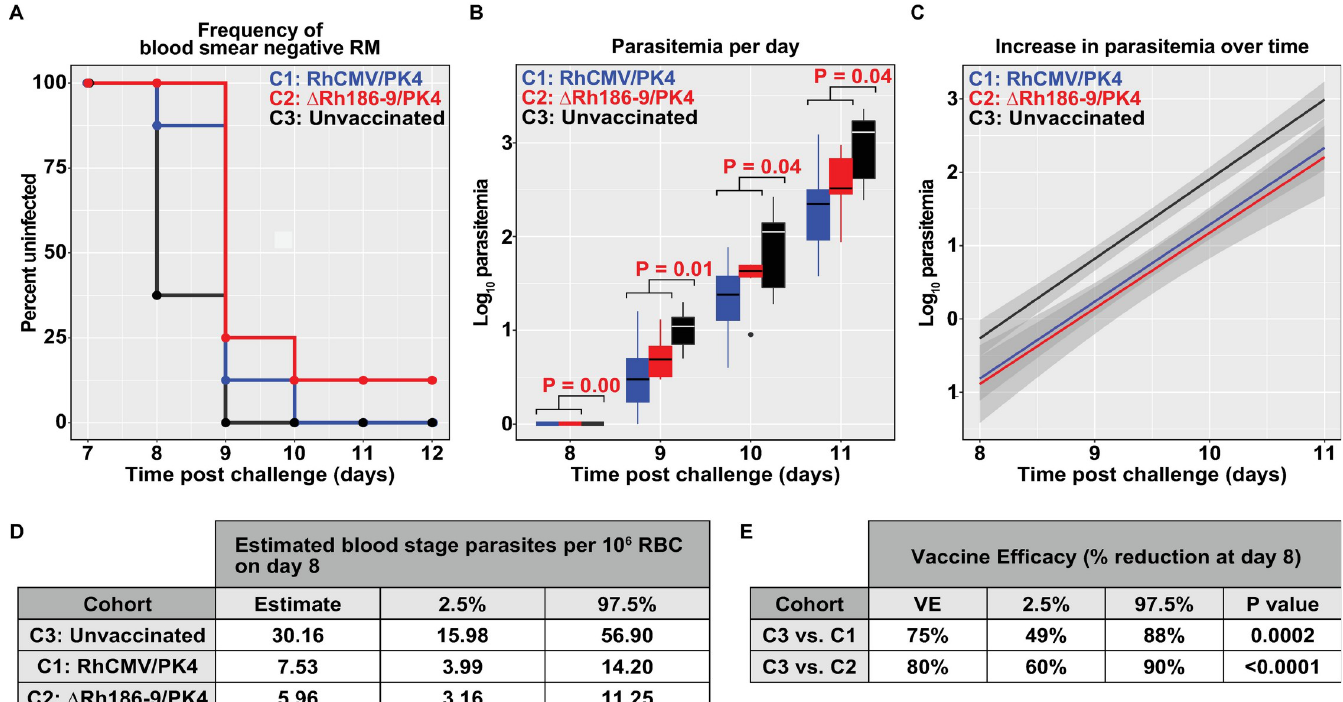
Fig 7. Blood stage parasitemia upon Spz challenge. Each cohort was challenged with 100 Spz at day 0 and blood stage parasitemia was monitored daily by Giemsa stained thin blood smears starting at day 6 post-challenge. (A) Percent of animals without detectable parasitemia at the indicated days post-challenge. The percentage of uninfected RM is shown for each cohort: C1 = animals immunized with the RhCMV/PK4 vector panel, C2 = animals immunized with the Δ Rh186-9/PK4 panel, C3 = non-immunized animals. (B) Boxplots of log10 parasitemia per 20,000 RBC at the indicated days show the median (horizontal line), interquartile range (shaded box), and range (whiskers and outlier points) among RM with detectable parasitemia, by day. Statistical significance as determined by unadjusted Wilcoxon test of C1 and C2 versus group C3 is shown above each plot. (C) Linear model fit to the log10-transformed parasitemia values with shaded bands indicating pointwise 95% confidence interval. The parasitemia data to days 8–11 fit a linear regression model and the intercepts for each of the vaccine groups differ significantly (P < 0.0001, ANOVA F test, see Methods) from the control group whereas the slopes did not differ (P = 0.9262). This corresponds to an impact on the number of parasites present on day 8. (D) Estimated mean day 8 parasitemia by group and 95% confidence interval are shown in units of 10 6 RBC. These are estimated from the coefficients of the group terms in a simple linear model relating parasitemia over days 8–11 post-challenge to day and group, as described in Methods. (E) Estimated percent reduction in mean day 8 parasitemia by treated group when compared to control RM, with 95% confidence intervals. These are estimated from the coefficients of the group terms in a simple linear model relating parasitemia over days 8–11 post-challenge to day and group, as described in